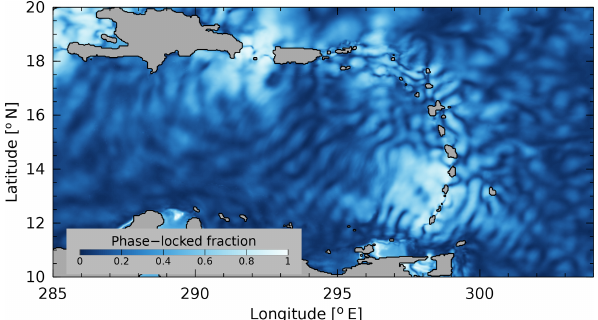
Figure 12. Fraction of variance: phase-locked versus total high- frequency variance (phase-locked plus non-phase-locked variance).